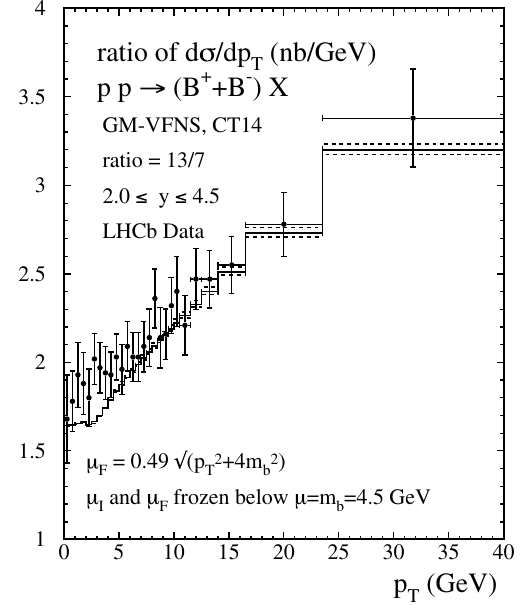
Fig. 7 Ratio R 13 / 7 of the B ± y distributions at √ S = 13 TeV to that at √ 7 TeV, integrated over p T in the range 0 ≤ p T ≤ 40 GeV. The black pointsrepresentthemeasuredvaluesfromtheLHCbCollaboration.The full-line histogram is the prediction with the default choice of scales using the CT14 PDF set. The dashed-line histograms represent the the- oretical uncertainties and the cross section is suppressed further at intermediate values of p T (cid:5) 4 − 12 GeV.